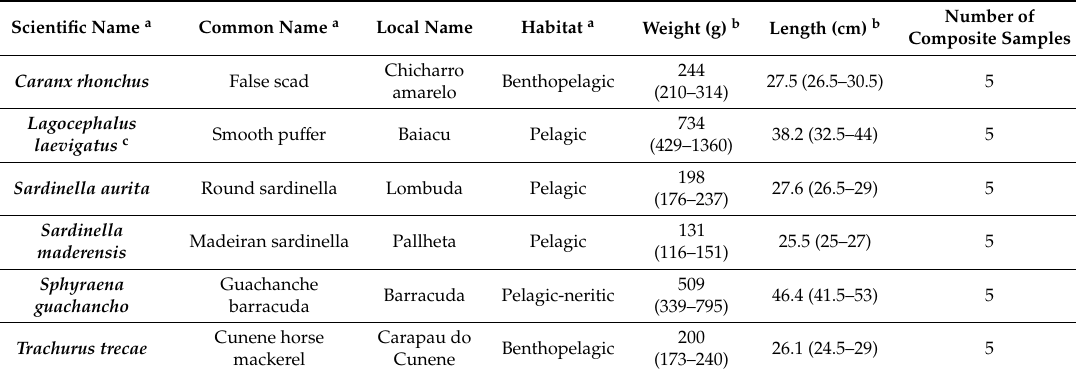
Table 1. Identification details and overview of fish species sampled from